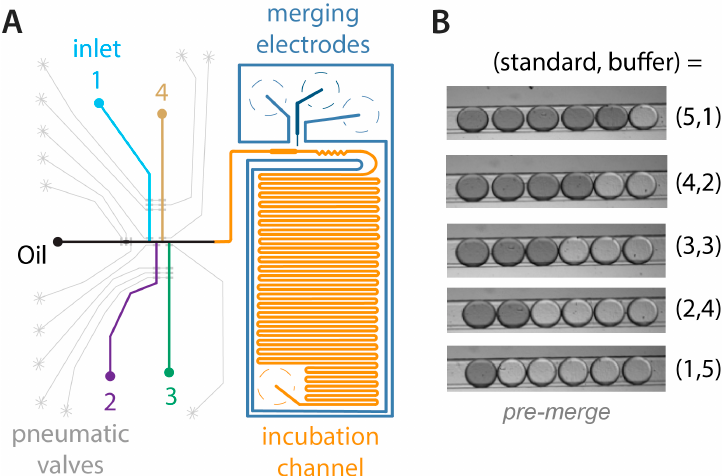
Figure 1. Microdevice design and operation. ( A ) Inlet aqueous reservoirs (1–4, colored) and one oil reservoir (black) were sampled by computer-controlled pumps based on pneumatic valves (light gray). Merging electrodes (dark blue) facilitated droplet coalescence in the widened merging region (orange), merged droplets were mixed in a zig-zag channel, and then assays were incubated in a long delay channel (orange) if needed prior to optical detection. ( B ) In this example, five ratios of standard mimics (dark) and buffer (transparent) were programmed on demand, then merged downstream. Images show the droplet groups prior to merging (see Videos S1 and S2).